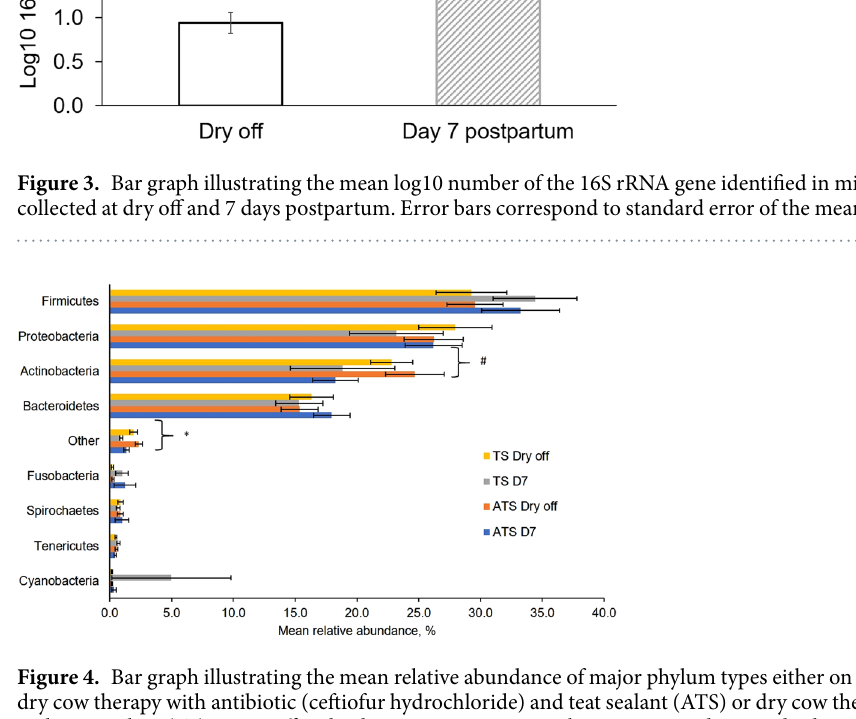
Table 2. The mean relative abundance for the 30 most common bacterial genera found throughout the different time points according to each treatment is presented in Table 1. Corynebacterium, Acinetobacter, Arthrobacter, Staphylococcus, and Psychrobacter were the top 5 most prevalent genera across treatments (Table 2). We performed a multivariable analysis to compare the mean relative abundance for bacterial genera known as major mastitis pathogens ( Escherichia spp., Klebsiella spp., Mycoplasma spp., Staphylococcus spp., and Streptococcus spp .). The use teat sealant with or without ceftiofur hydrochloride at dry off did not affect the mean relative abun- dance of these major genera of mastitis-associated pathogens (Fig. 5A–F).